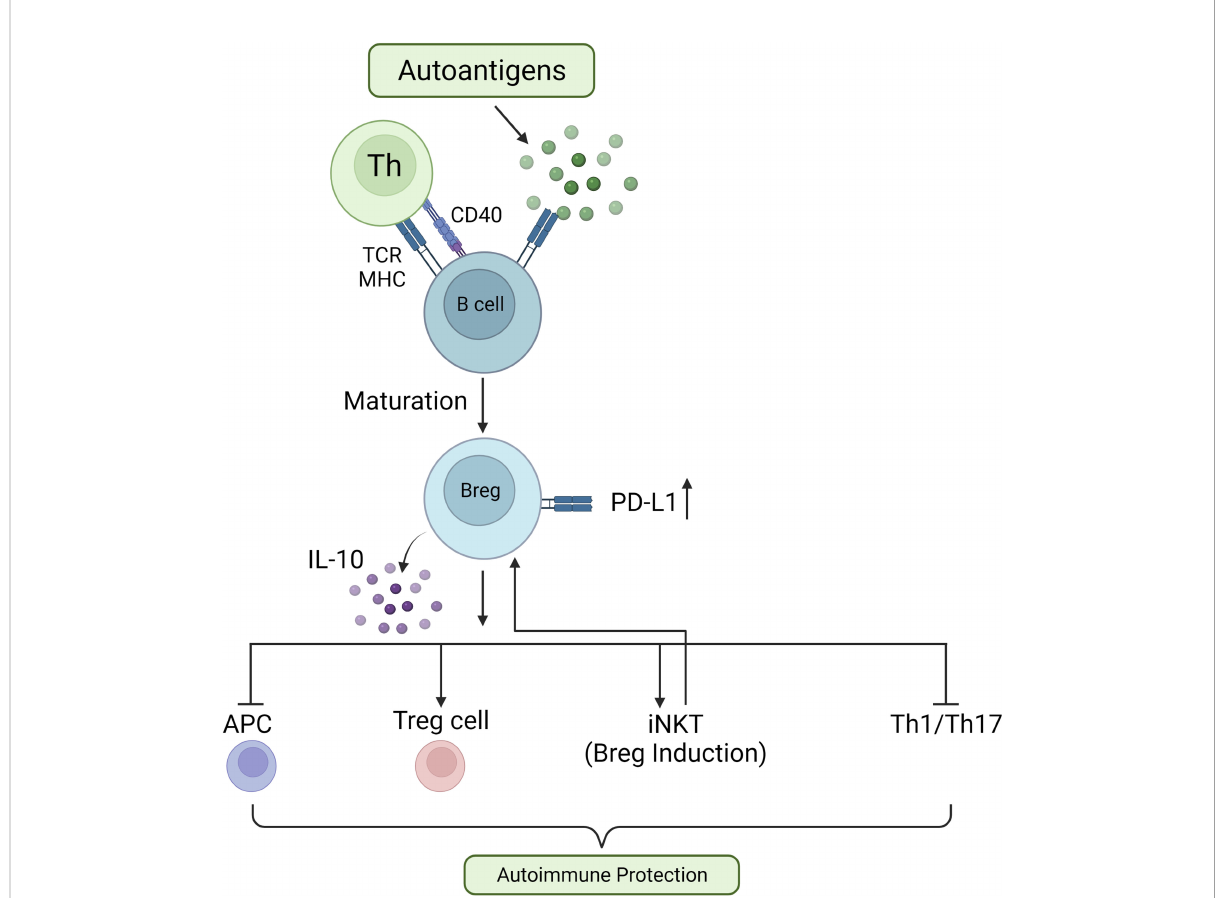
FIGURE 2 Role of Breg cells in preventing autoimmune reactions. In response to autoantigens, autoreactive B cells interact with T helper (Th) cells via TCR/MHC and CD40L/CD40, driving B cell differentiation into Breg cells. These IL-10-secreting Breg cells quell in fl ammatory responses by inhibiting APCs, increasing Treg cell activity, increasing invariant Natural Killer-like T (iNKT) cell numbers, and suppressing Th1 and Th17 cell